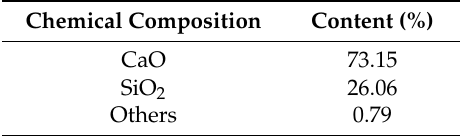
Table 1. Chemical composition of synthesized C 3